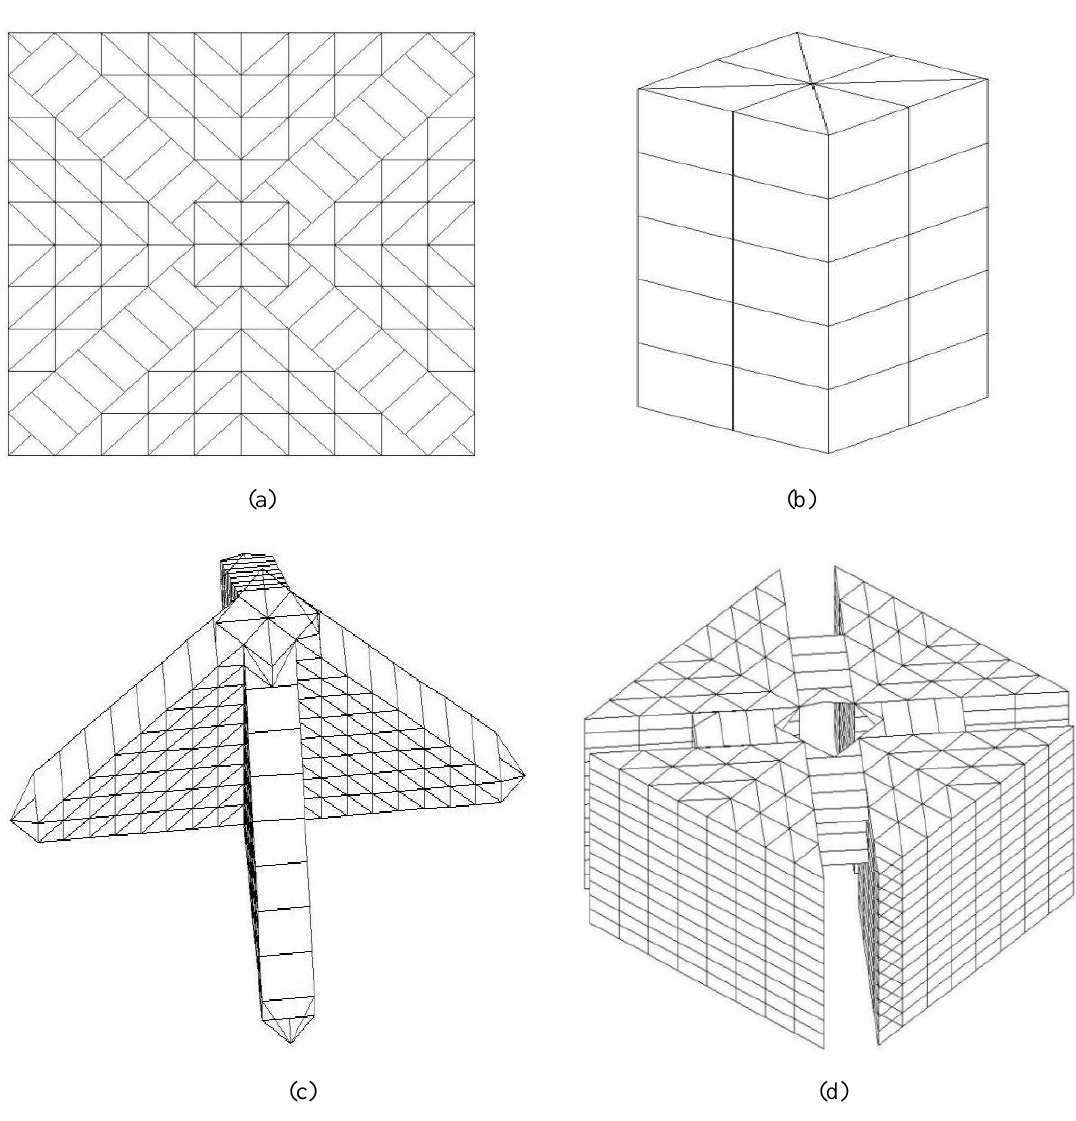
Figure 6.Top view of the final footing form for (a), column of the final footing form for (b), four foothills at the terminal iteration for (c) and form of inefficient perturbations Ω 𝜎̃ 4.7 Variation of initial volume at a finite number of iterations and different rates in Figures 7 and